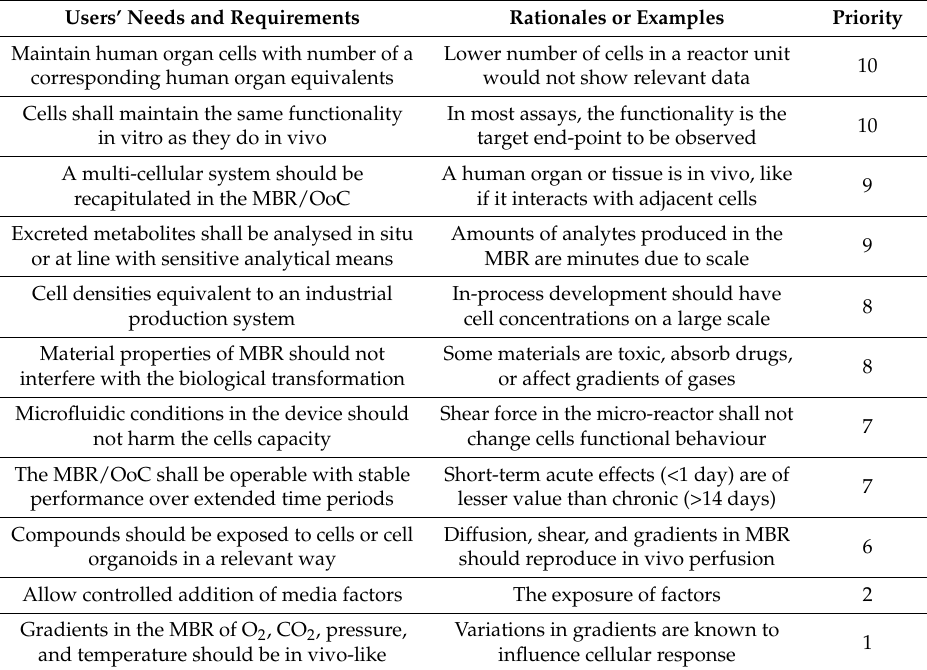
Table 1. Examples of common user needs of micro-bioreactors and organ-on-chips.